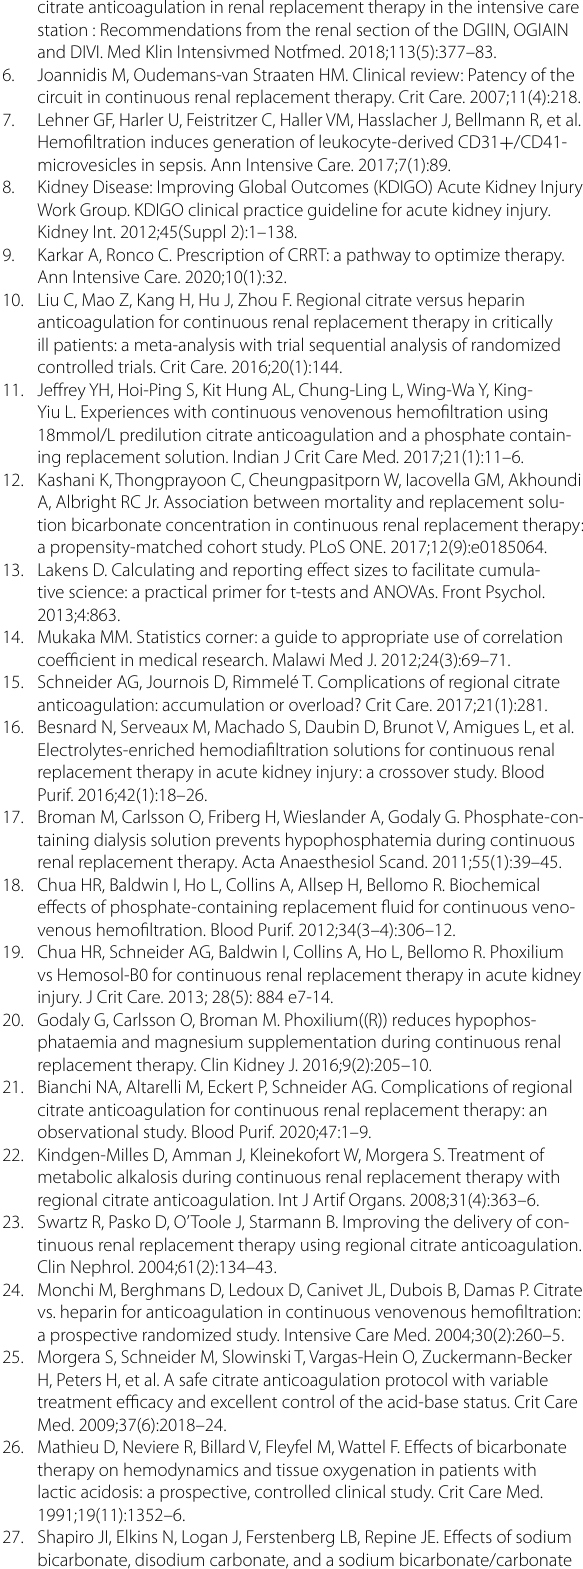
Additional file 2: Figure S2. Sensitivity analysis comprising 26 patients with a complete dataset from